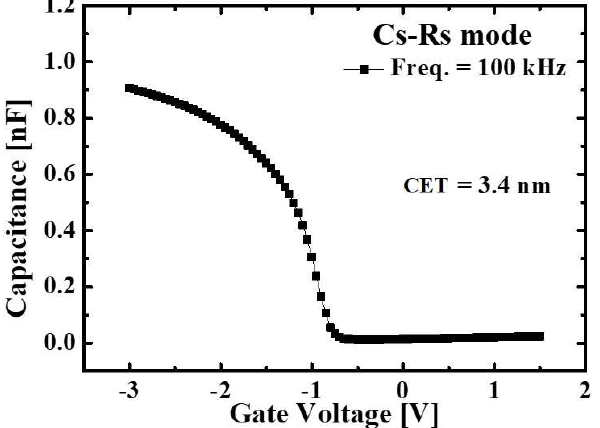
Figure 5. Measured C-V curves of MOS capacitors. The measured CET is 3.4 nm.